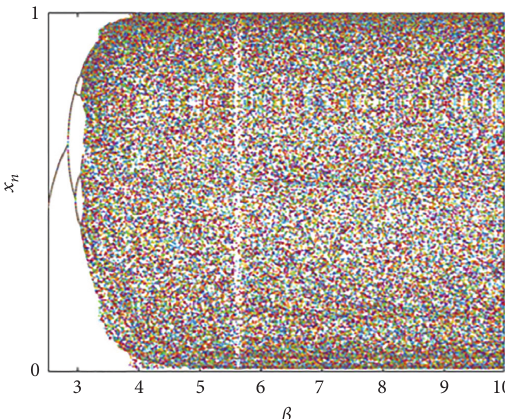
Figure 4: Bifurcation diagram of quantum logistic